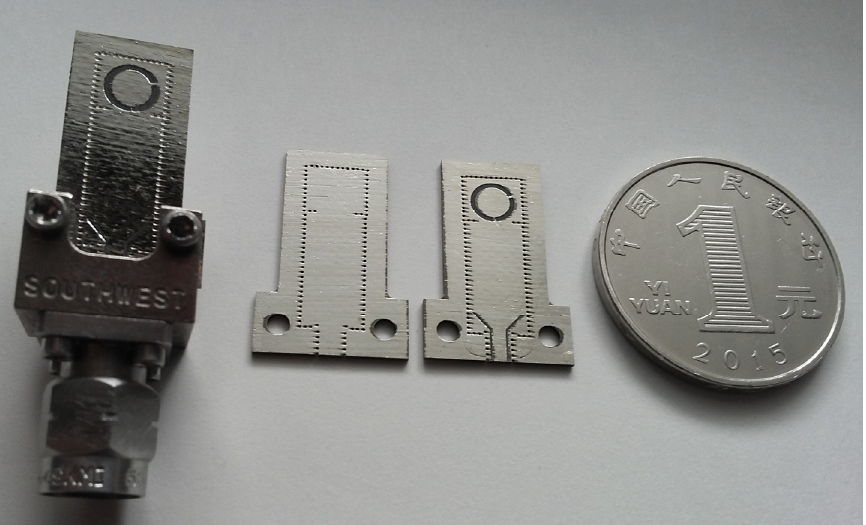
Figure 5. Photograph of the fabricated antenna with Southwest ® end launcher (SEL).